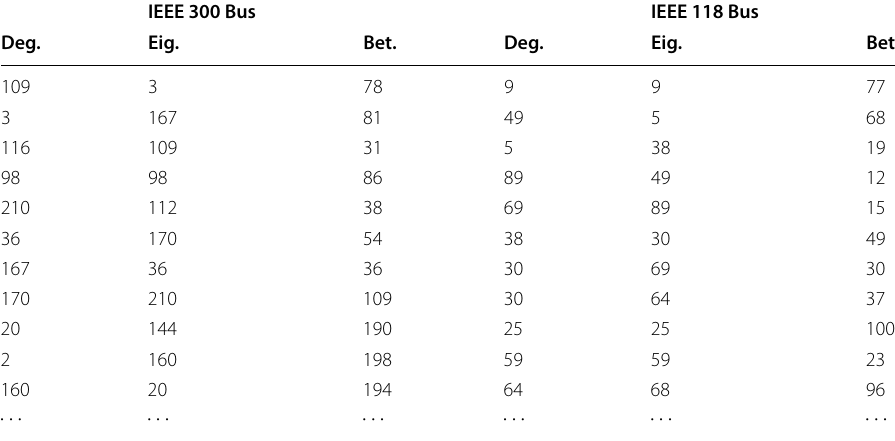
Table 1 Buses removed under the ICME according to different centrality measures IEEE 300 Bus IEEE 118 Bus Deg. Eig. Bet. Deg. Eig.